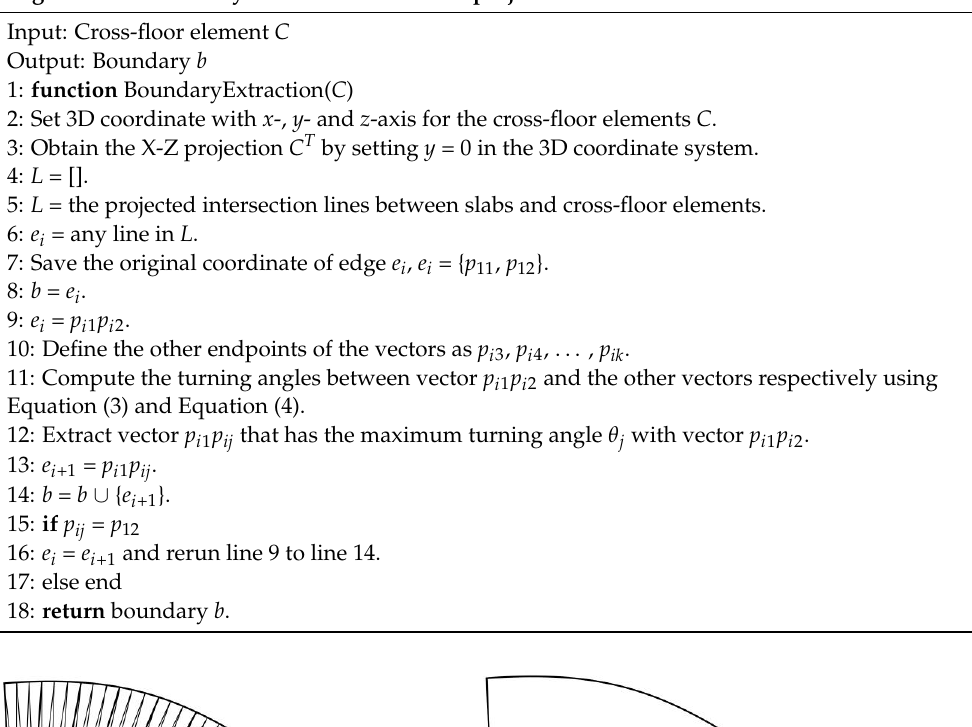
Algorithm 1. Boundary extraction for the X-Z projection